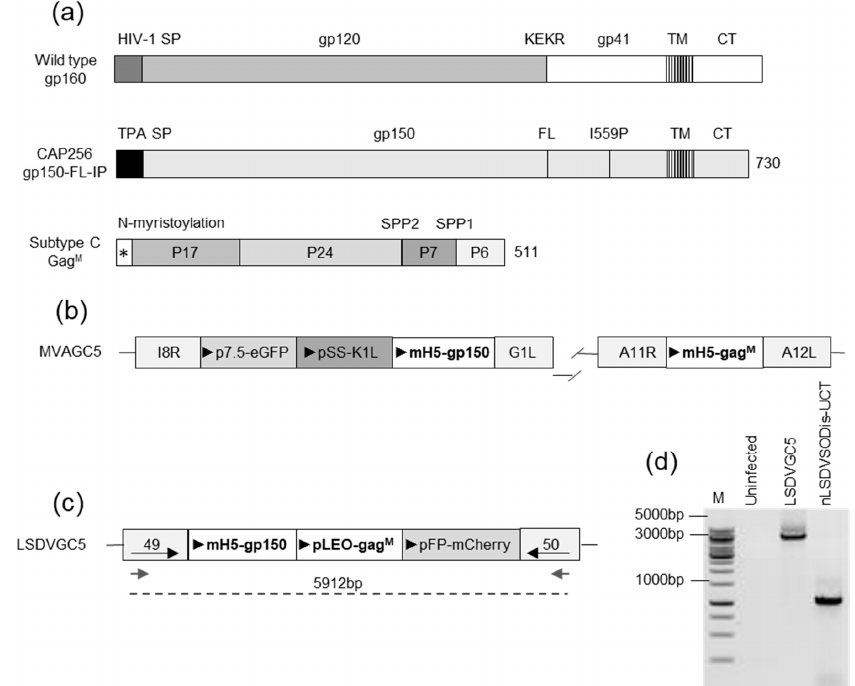
Figure 1. The design of vaccines. ( a ) The schematic representations of gene coding sequences for the HIV wild-type gp160 envelope, the gp150-FL-IP envelope immunogen, and the subtype C mosaic Gag (Gag M ). The native signal sequence (HIV-1 SP) was replaced with the tissue plasminogen activator signal sequence (TPA SP) for the gp150 antigen, the furin cleavage site (KEKR) was replaced with a flexible linker (FL), and an I559P mutation was included. The gp150 protein was truncated at amino acid 730. TM—transmembrane domain and CT—cytoplasmic tail. No additional modifications were made to the subtype C mosaic Gag [46], *—N-myristoylation. ( b ) A diagram showing the design of MVAGC5. The expression cassette containing the gp150 was inserted between ORFs I8R and G1L and the Gag M between ORFs A11R and A12L. ( c ) A diagram showing the design of LSDVGC5. An expression cassette containing gp150 and Gag M was inserted between ORFs 49 and 50. The gray arrows indicate the primers used for PCR and the dotted line indicates the fragment amplified by PCR. ( d ) The PCR confirmation of LSDVGC5. DNA was extracted from MBDK cells infected with LSDVGC5 and subjected to PCR. Fragments were separated by agarose gel electrophoresis. M = GeneRuler 1kb DNA ladder (Thermo Fisher Scientific, Waltham, MA,